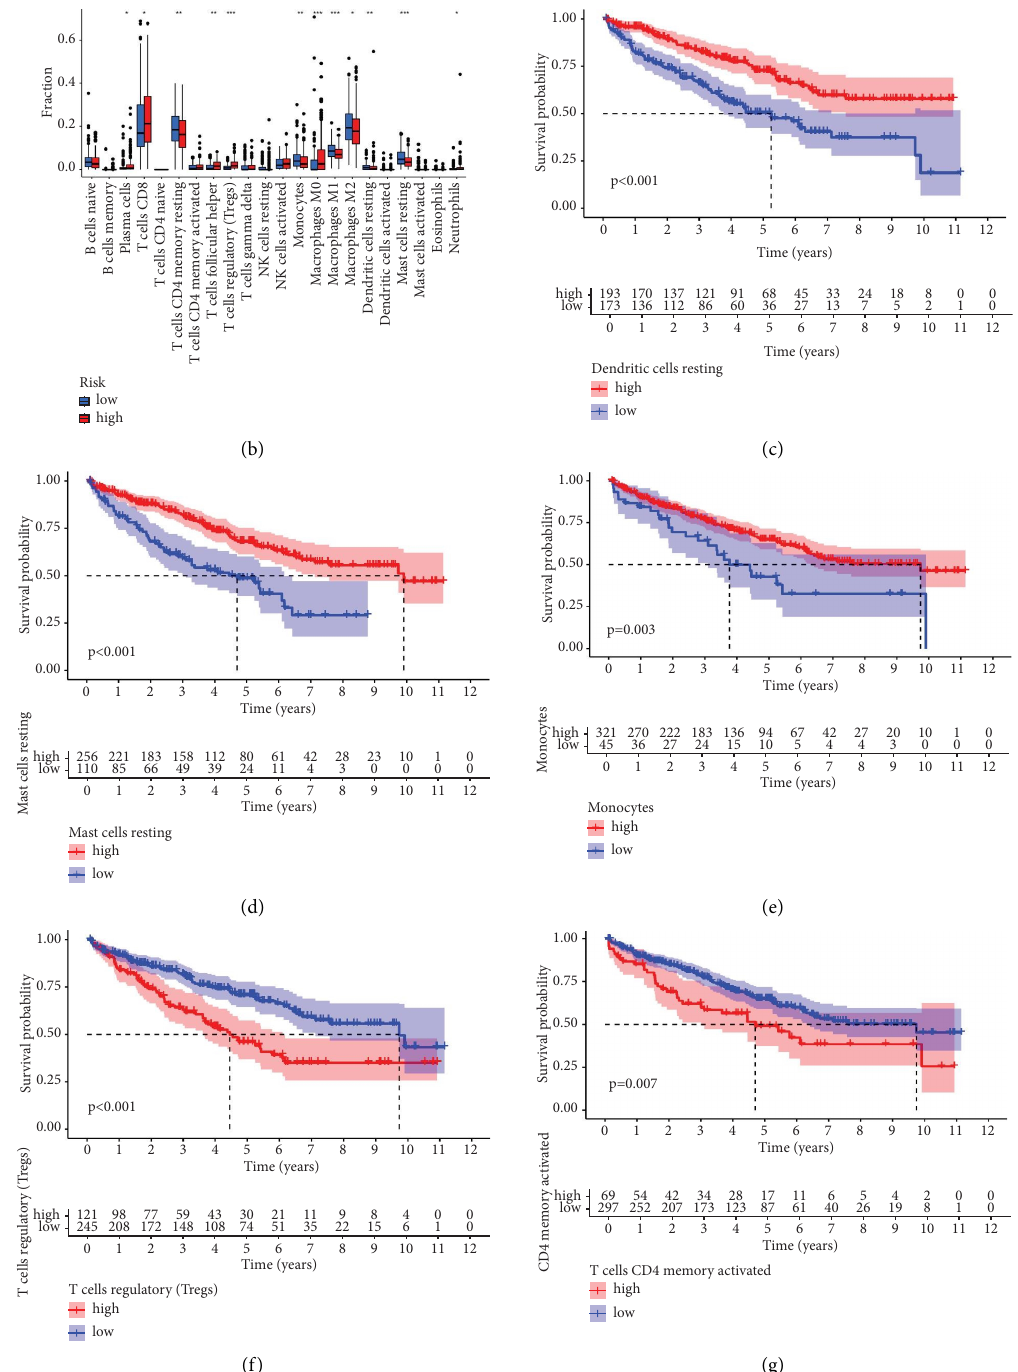
Figure 4: (a)–(b) Te diference in immune cells between low- and high-risk groups. (c) Survival analysis based on the resting T cells expression level. (d) Survival analysis based on the resting mast cells expression level. (e) Survival analysis based on the expression monocytes level. (f) Survival analysis based on the regulatory T cells expression level. (g) Survival analysis based on the activated T cells expression